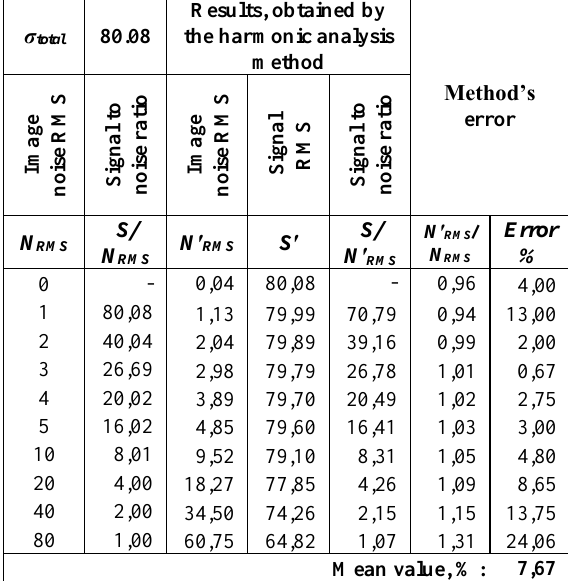
Table 1. The results of random noise assessment N RMS for the test images sample based on harmonic analysis